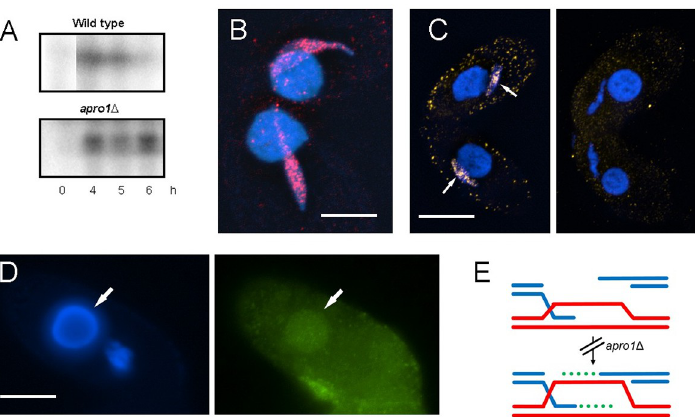
mutant (right). D. EGFP-tagged Apro1 (green) localizes to the somatic nucleus (arrow). Bars: 10 μ m. E. Model showing a hypothetical arrested recombination intermediate in the apro1 Δ mutant. In the wild type, invasion of a homologous DNA tract by two ends of a broken DNA is followed by gap-filling repair synthesis (green dots). In apro1 Δ , a single DNA end invading a homologous region is not elongated by newly synthesized DNA, but the limited heteroduplex is sufficient to hold homologs together. The other end does not invade, explaining the persistent DNA fragments seen in